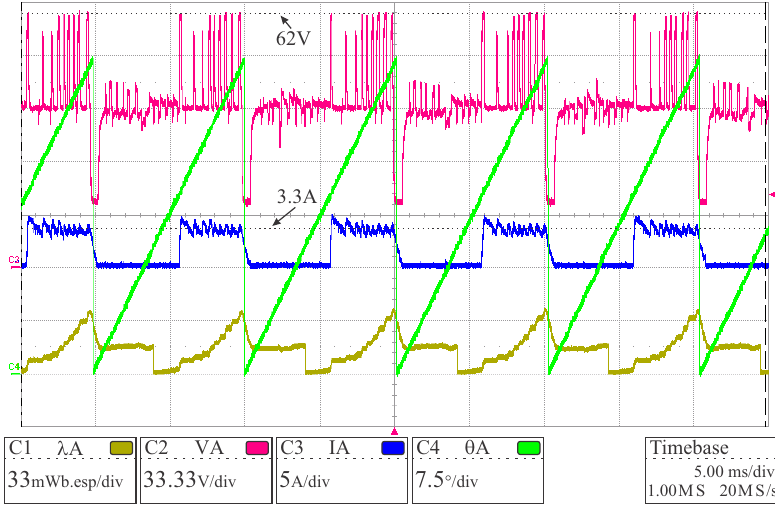
Figure 12. Experimental results with the resettable integrator.